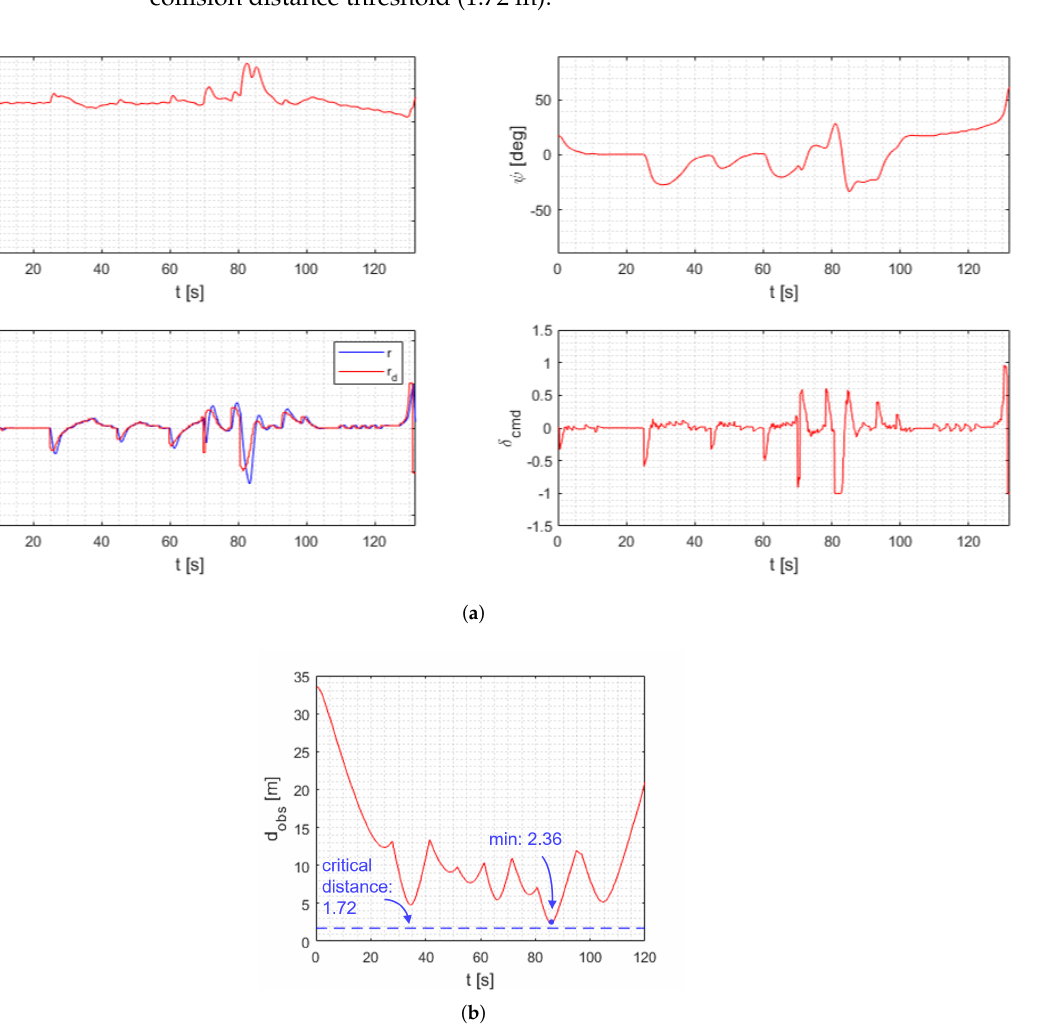
Figure 17. Variables in the scenario with fixed and mobile obstacles. ( a ) State variables of the USV. ( b ) Distance to the closest